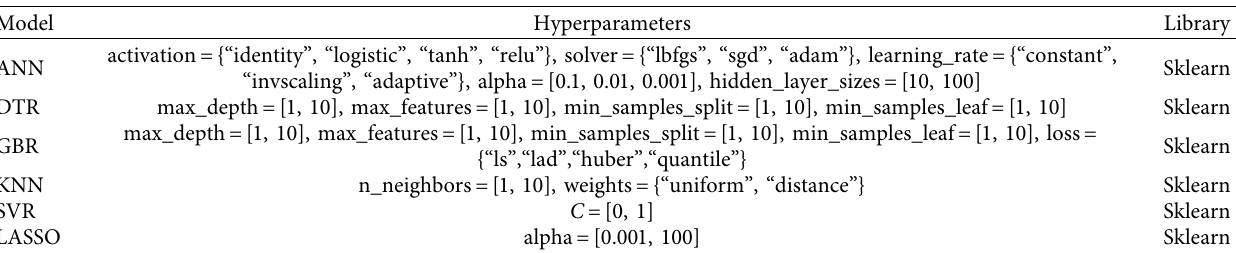
Table 2: Hyperparameters of each algorithm.